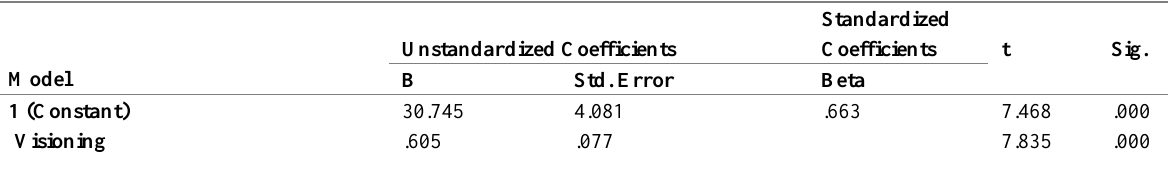
Table 1: Regression Coefficients